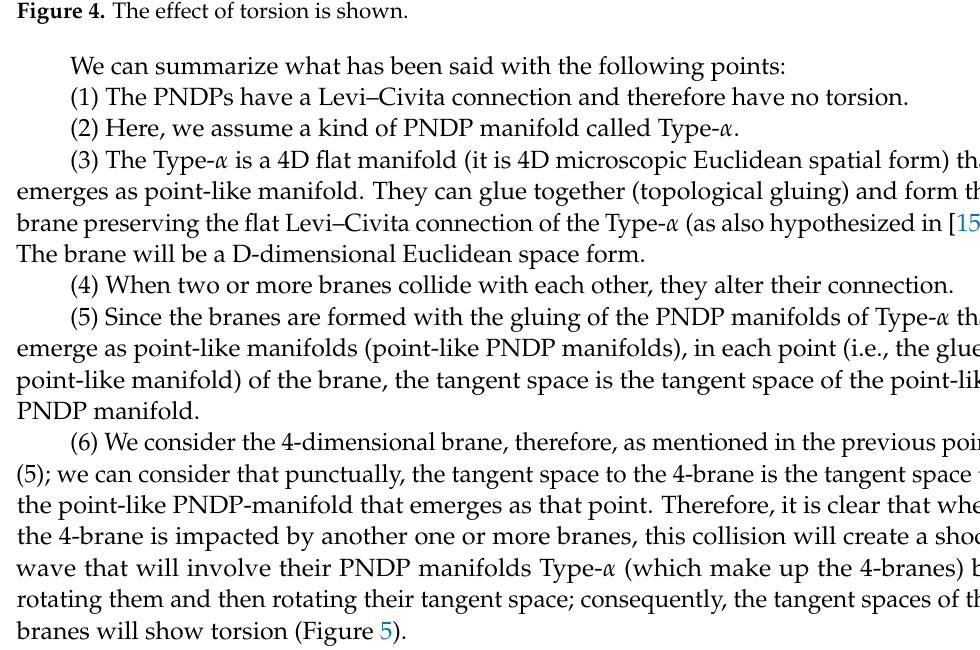
Figure 4. The effect of torsion is